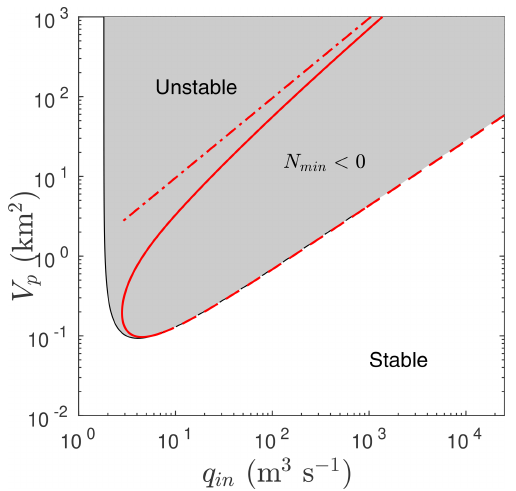
Figure 7. The stability boundary of Fig. 2 for L = 50km plotted in black, with the region of parameter space in which the steady state is unstable shown in grey. The red curve is the set of parameter combi- nations (q in ,V p ) for which there is a periodic solution that reaches a minimum effective pressure of N = 0. The minimum effective pres- sure becomes negative inside the region delineated by the red curve. Note that this region extends slightly beyond the right margin of the grey-shaded unstable region: this small strip is the region where sta- ble limit cycles coexist with steady-state solution; see for instance the inset of Fig. 5b. The dotted–dashed curve is the asymptotic for- mula 15 for the threshold value of q in at which negative N is first